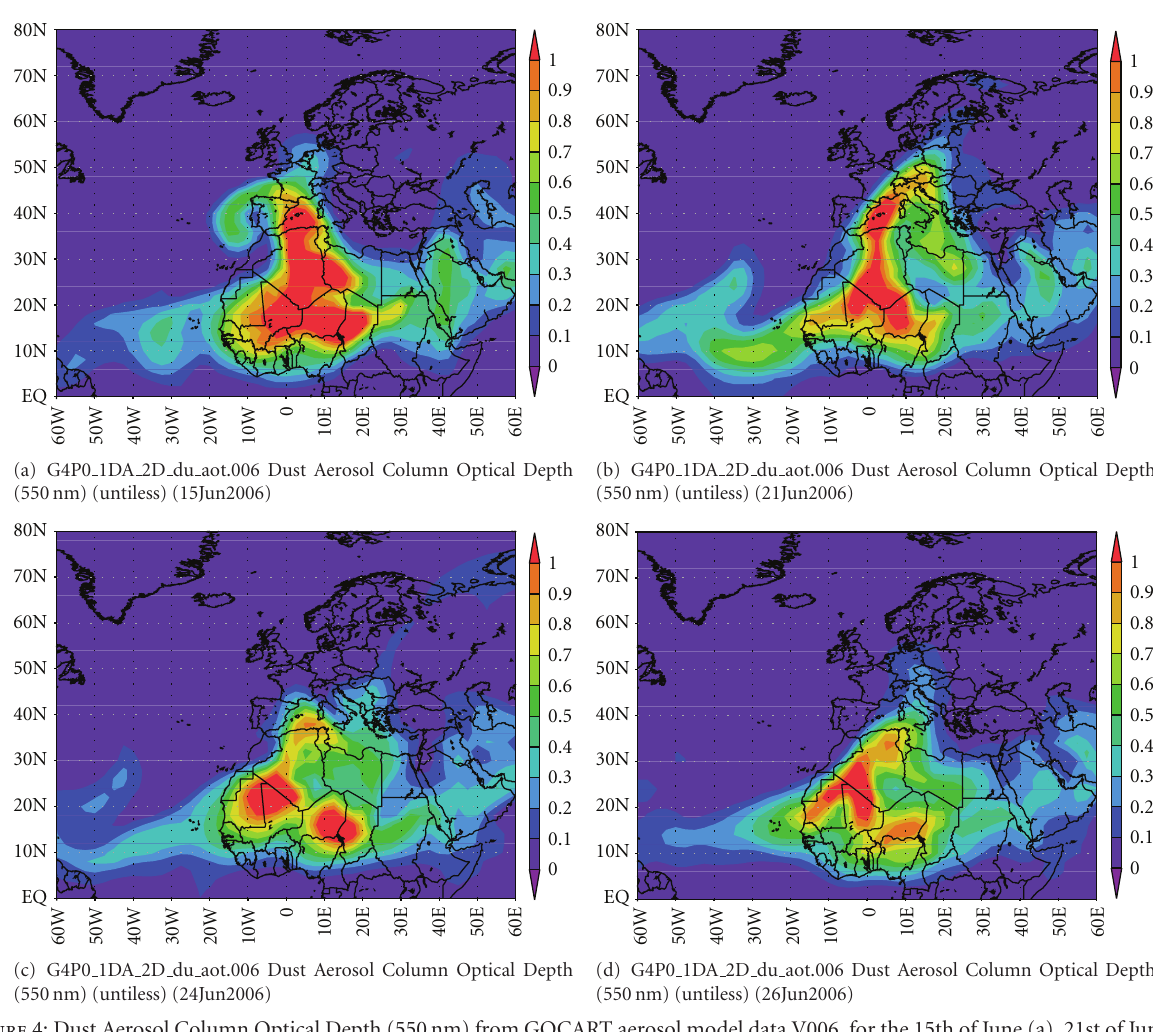
Figure 4: Dust Aerosol Column Optical Depth (550nm) from GOCART aerosol model data V006, for the 15th of June (a), 21st of June (b), 24th of June (c), and 26th of June (d)